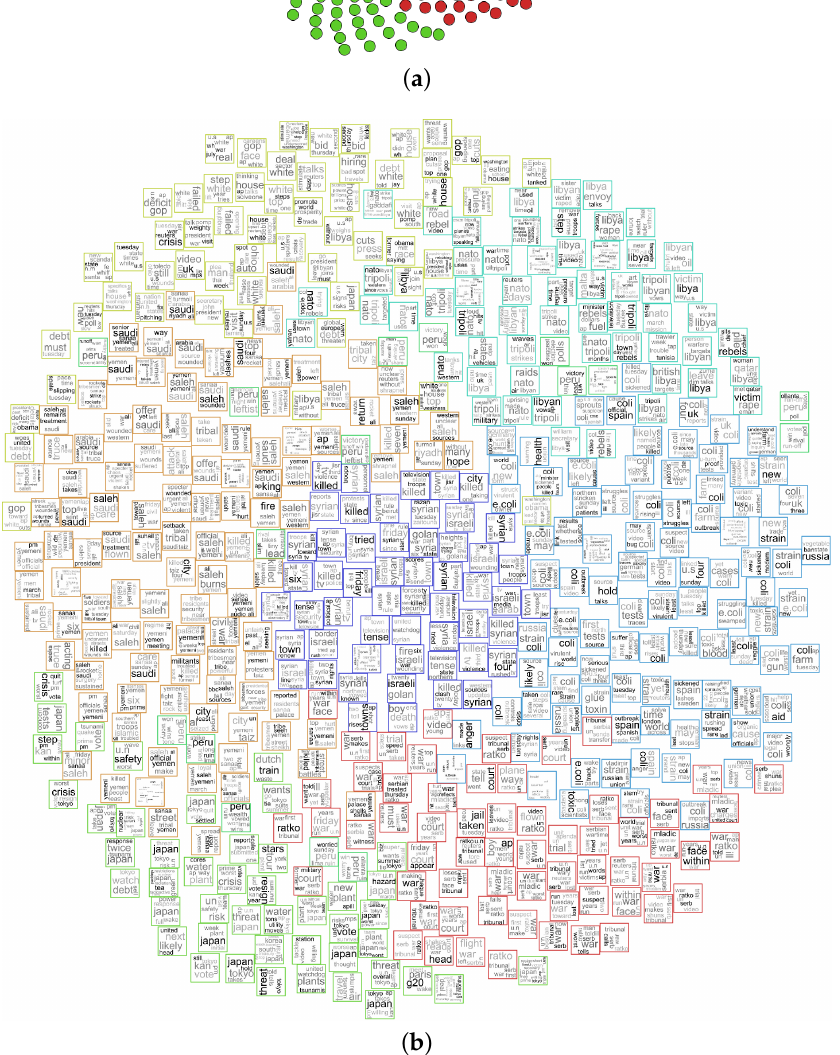
Figure 13. Overlap removal technique applied in the projection of the NEWS-8 dataset presented in Figure 9. The RWordletechnique removed the overlapping of points ( a ) and images ( b